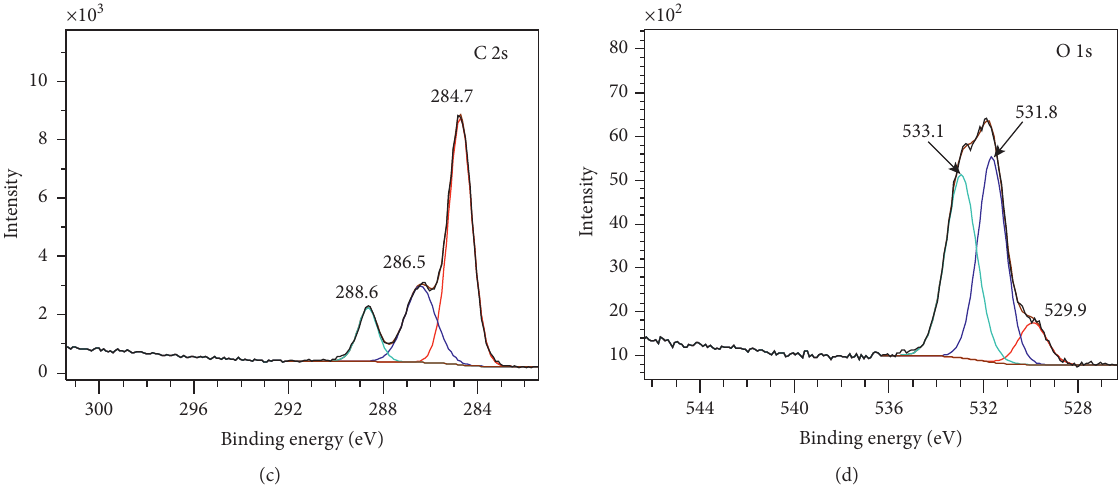
Figure 4: XPS spectra of the MIL-53(Fe) sample synthesized at the molar ratio FeCl survey spectrum; (b) Fe2p; (c) C2s; (d)